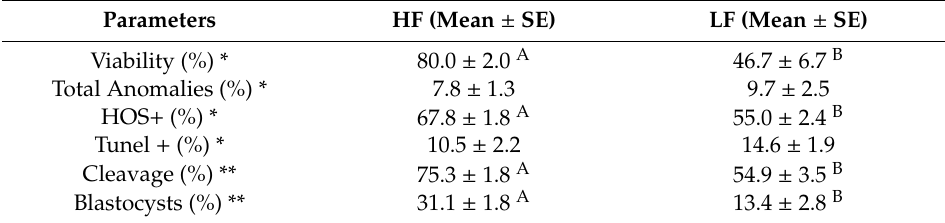
Table 1. Values of p Corrected and Log2Fold Change of putatively identified metabolites in fresh and cryopreserved seminal plasma (F-P and CRY-P) and fresh and cryopreserved spermatozoa (F-S and, CRY-S) samples ( t -test with p -value < 0.05 and fold change > 2.0). Table 2. Post-thawing morphological and functional sperm parameters in high fertility (HF, n = 4), and low fertility (LF, n = 4)